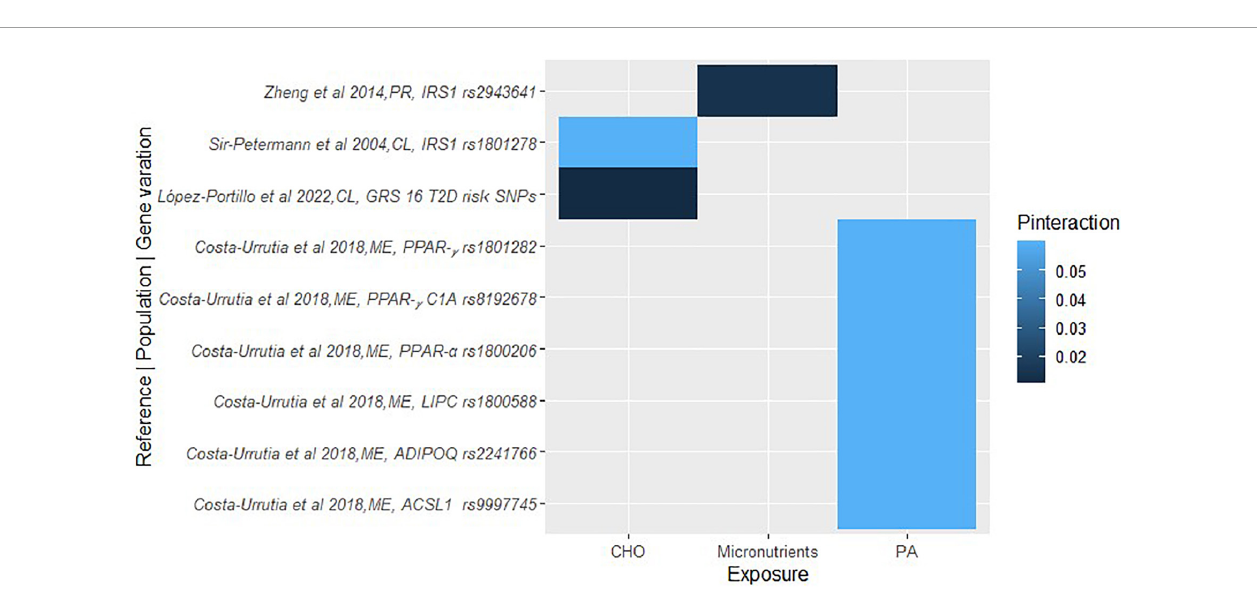
FIGURE4 A heat map showing the findings for gene-lifestyle interactions on diabetes traits. López-Portillo et al. (161), GRS-16 Type 2 Diabetes (T2D) risk SNPs = MTNR1B (rs10830963); TCF7L2 (rs7903146); CDKAL1 (rs7756992); ADCY5 (rs11717195); ANK1 (rs516946); BCAR1 (rs7202877); CDC123 (rs11257655); DUSP9 (rs5945326); GRB14 (rs3923113); RASGRP1 (rs7403531); TLE4 (rs17791513); TLE1 (rs2796441); ZBED3 (rs6878122)